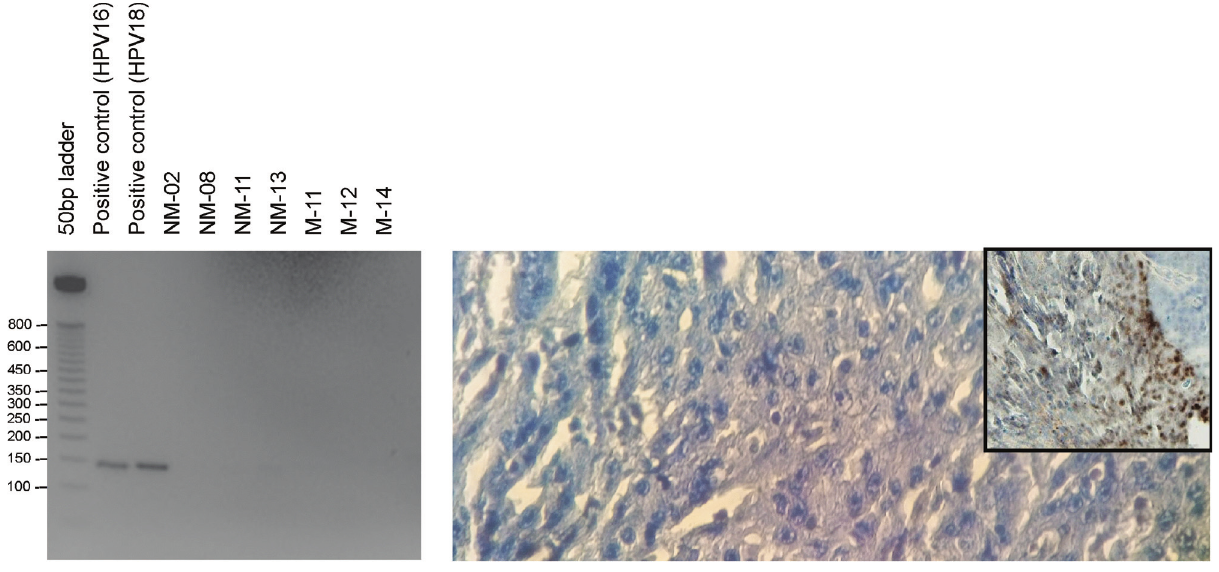
Figure 1 - Human papilloma virus (HPV) detection. PCR (left) for HPV detection using GP5/GP6 primers (expected product ~150bp). HPV in situ hy- bridization (right) using GenPoint in a representative HPV-negative HNSCC sample at a magnification of 40 x 10X; inset at magnification of 4 x 10X shows control HPV-positive nuclei stained brown.